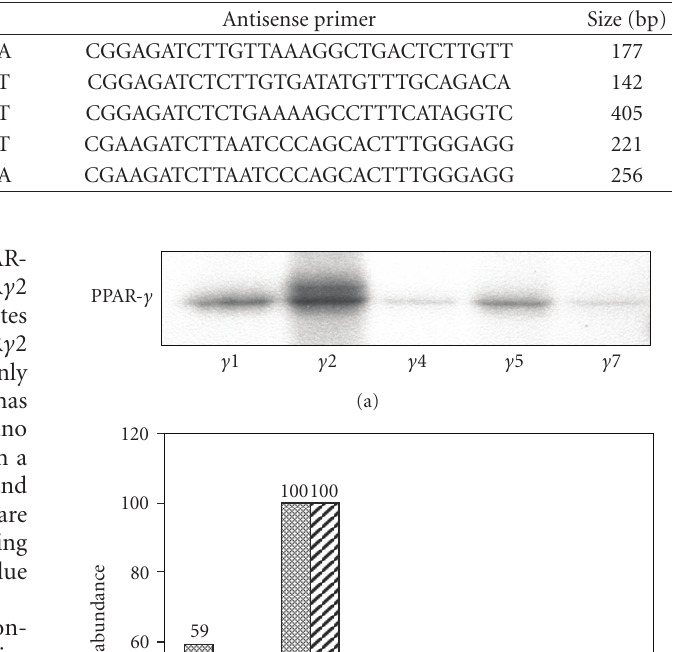
Table 1: Primers for amplification of di ff erent PPAR- γ 5 (cid:2) -UTRs.